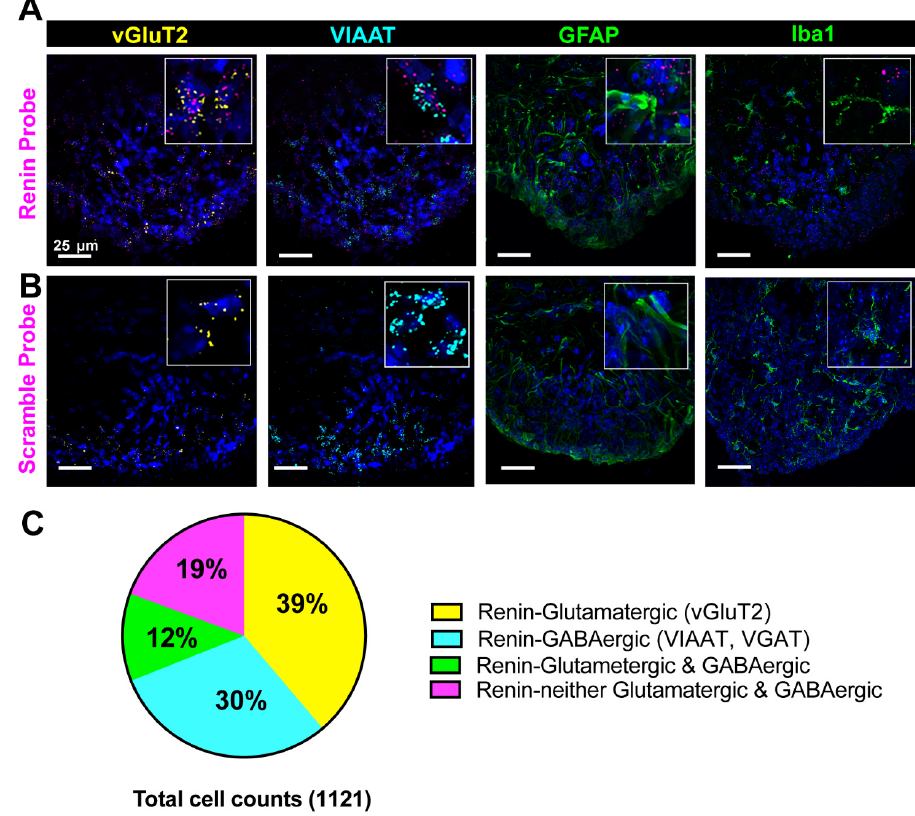
Figure 2. Cell type expression of renin in the SFO. Renin mRNA and mRNAs for nucleus-specific GABAergic and glutamatergic neuron markers were detected in the mouse brain (n = 4 mice) using RNAScope in situ hybridization. Cells were immunolabeled for astrocytes (GFAP) and microglia (Iba1) markers. ( A ) Representative confocal images of renin mRNA in the SFO and ( B ) scrambled renin probe (negative control). Magenta, renin; yellow, glutamatergic neurons (vGluT2); cyan, GA- BAergic neurons (VIAAT); green, astrocyte marker (GFAP) or microglia marker (Iba1). Tissues were counterstained with DAPI (blue). ( C ) Summary data showing the cellular distribution of renin mRNA in GABAergic and/or glutamatergic neurons. Abbreviations: SFO, subfornical organ; vGluT2, vesicular glutamate 2; VIAAT, vesicular inhibitory amino acid transporter; GFAP, glial fi- brillary acidic protein; Iba1, ionized calcium binding adaptor molecule 1.